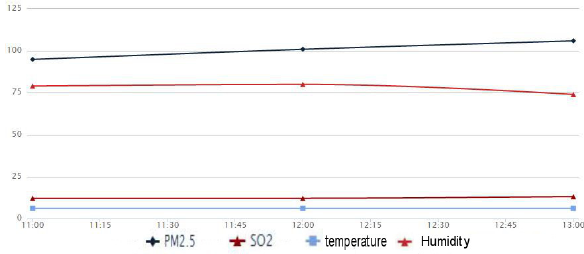
Figure 8. Some data of air quality from the government website